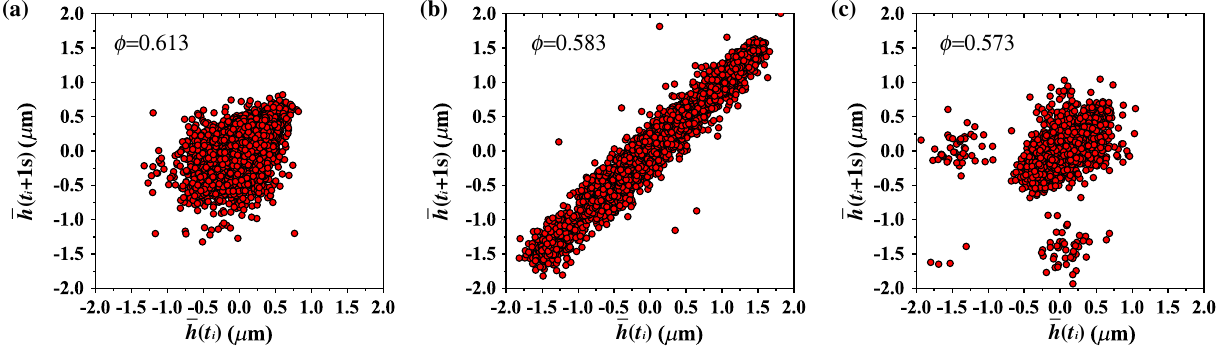
¯ 1 s Þ versus ¯ h ð t h ð t for the grain boundary with θ ¼ 28 ° at (a) ϕ ¼ 0 . 613 , (b) ϕ ¼ 0 . 583 , and (c) ϕ ¼ 0 . 573 i þ i Þ